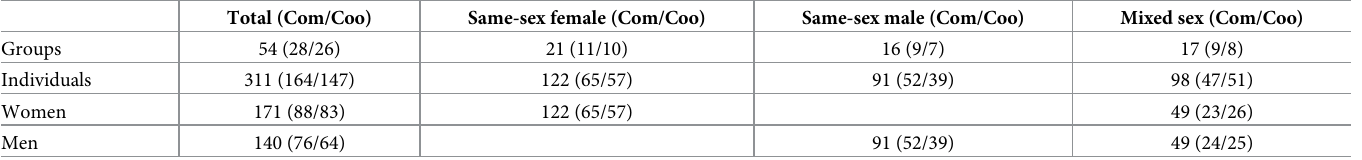
Table 3. Number of groups and participants per group type and condition.